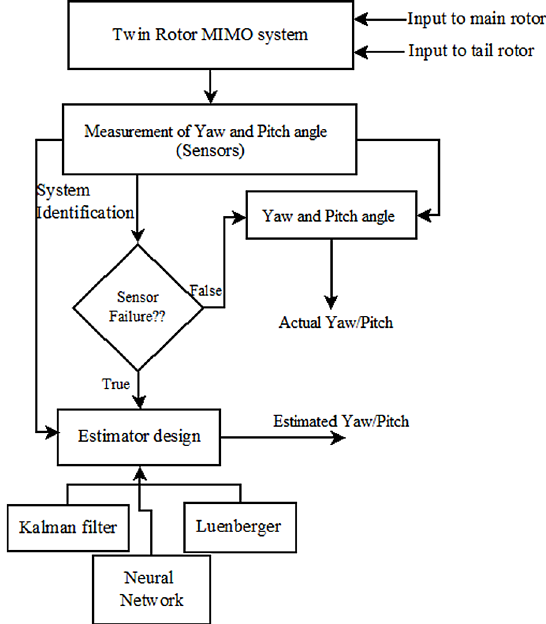
Figure 2. Outline of the proposed